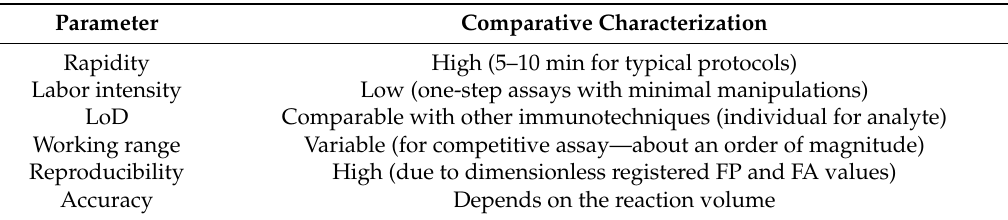
Table 2. Estimation of FPA parameters (using data from